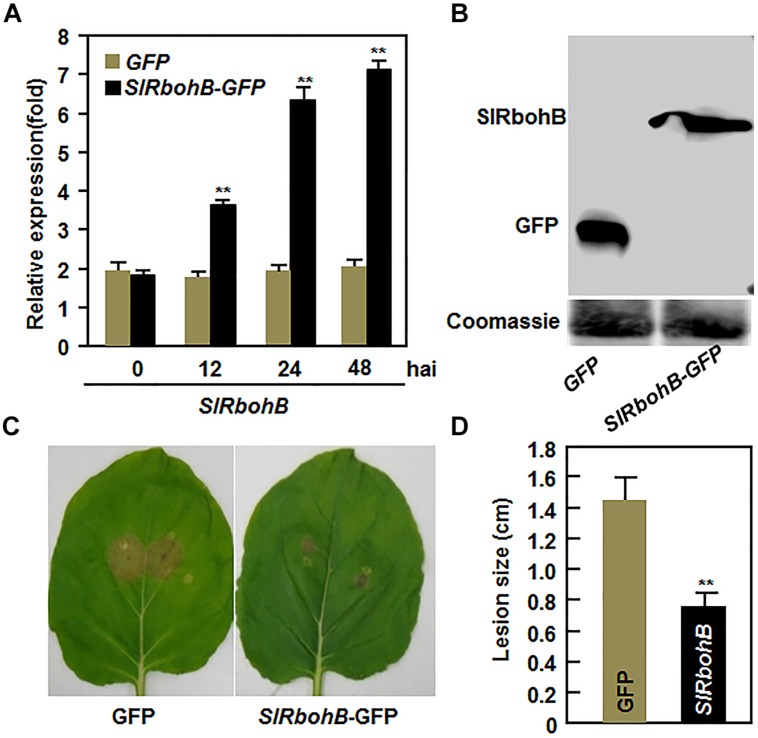
Transient expression of SlRbohB in Nicotiana benthamiana conferred an increased resistance to B. cinerea. Agrobacteria harboring pFGC-SlRbohB or pFGC-eGFP were infiltrated into leaves of 4-week-old N. benthamiana plants and leaf samples were collected for different assays. (A) Expression of SlRbohB in pFGC-SlRbohB-infiltrated leaves. (B) The SlRbohB-GFP fusion protein in pFGC-SlRbohB-infiltrated leaves. Leaf samples were harvested 48 h after infiltration, total soluble proteins were separated by SDS–PAGE, and analyzed by immunoblotting using a GFP-specific antibody. Equal loading of total proteins was verified by Coomassie blue staining. (C) Disease symptom on representative leaves. (D) Lesion sizes. The pFGC-SlRbohB- and pFGC-eGFP-infiltrated leaves were detached at 48 h after infiltration and inoculated by dropping spore suspension (2 × 105 spores/mL). Photos were taken and lesion sizes were measured on a minimum of 10 leaves at 5 days after inoculation. Data presented in (A,D) are the mean ± SD from three independent experiments and ** above the columns indicate significant difference at p < 0.05 level.